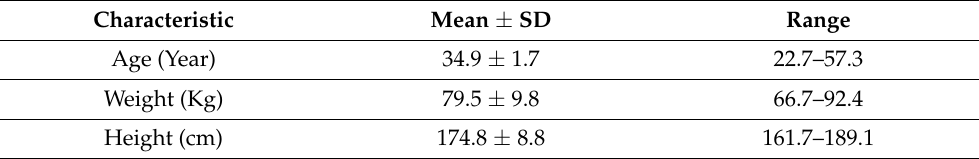
Table 3. Characteristics of the study’s